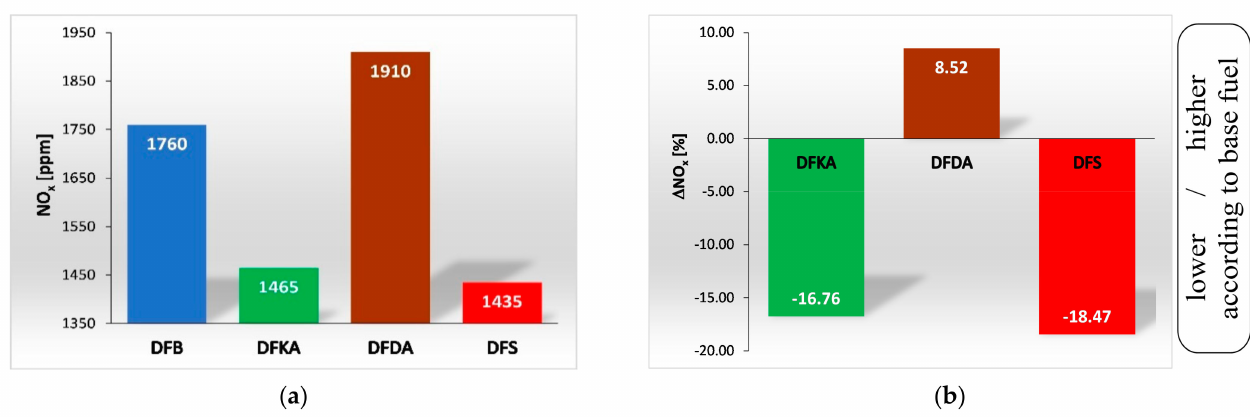
Figure 10. Factors influencing reduction in NO x and PM emissions in exhaust gas of engine fuelled with DFS (with both tested additives).